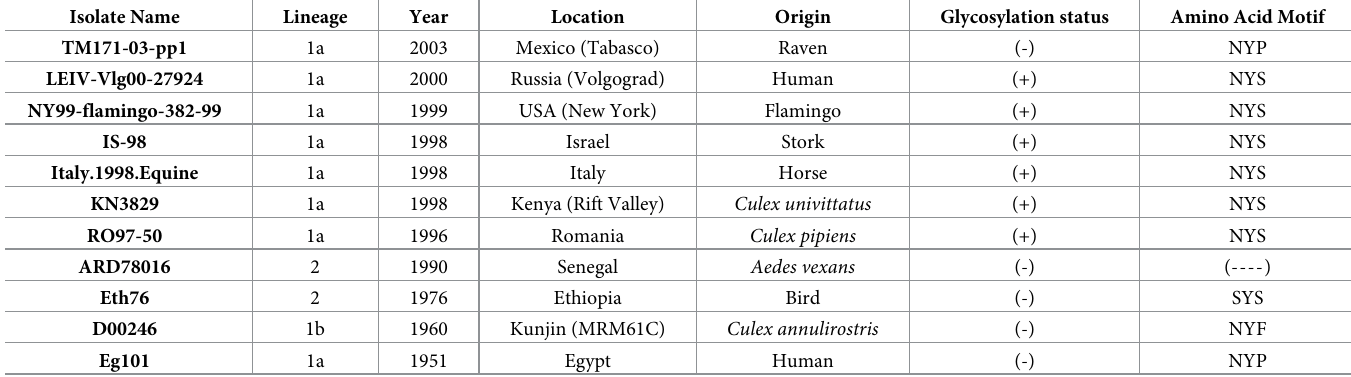
Table 1. Summary of West Nile virus strains including origin of isolation, glycosylation status and associated amino acid motif. Isolate